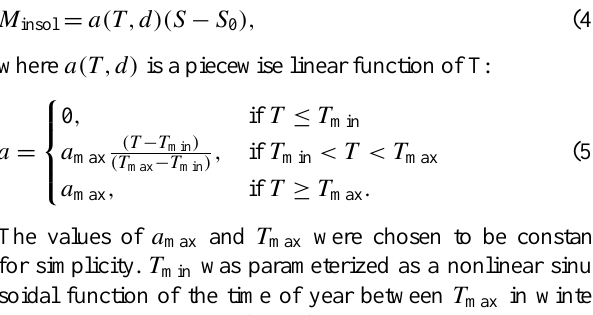
role in increasing melt and thus in further decreasing the albedo. It is there that the insolation-related melt anomaly has the largest absolute